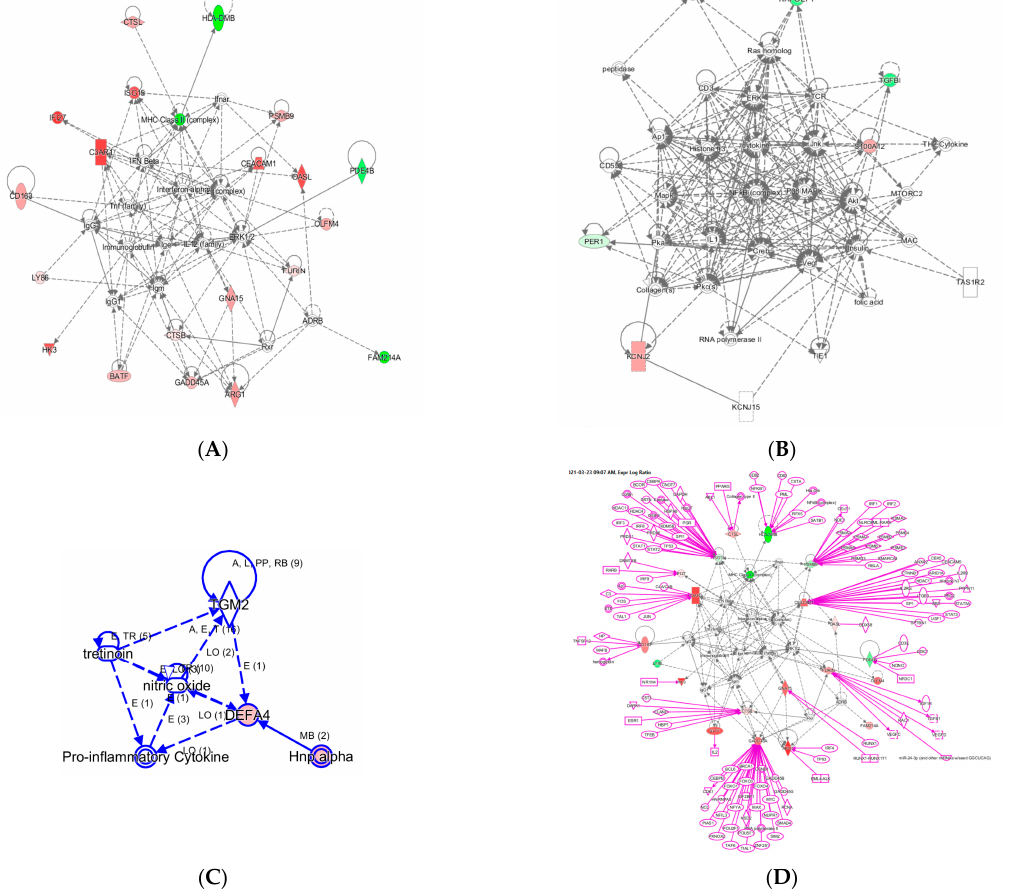
Figure 3. Three networks built with the 29 InSep genes as input seed nodes ( A – C ). The directionality of relative changes for each gene (red for over-expressed and green for under-expressed) are referred to the comparison of viral infection versus uninfected control. ( D ) is an extended network grown on network ( A ). The added part was shown as purple color. Network A has a total of 35 nodes; of the 29 InSep genes, 20 are found in this network, either over-expressed (red) or under-expressed (green) in viral infection in comparison